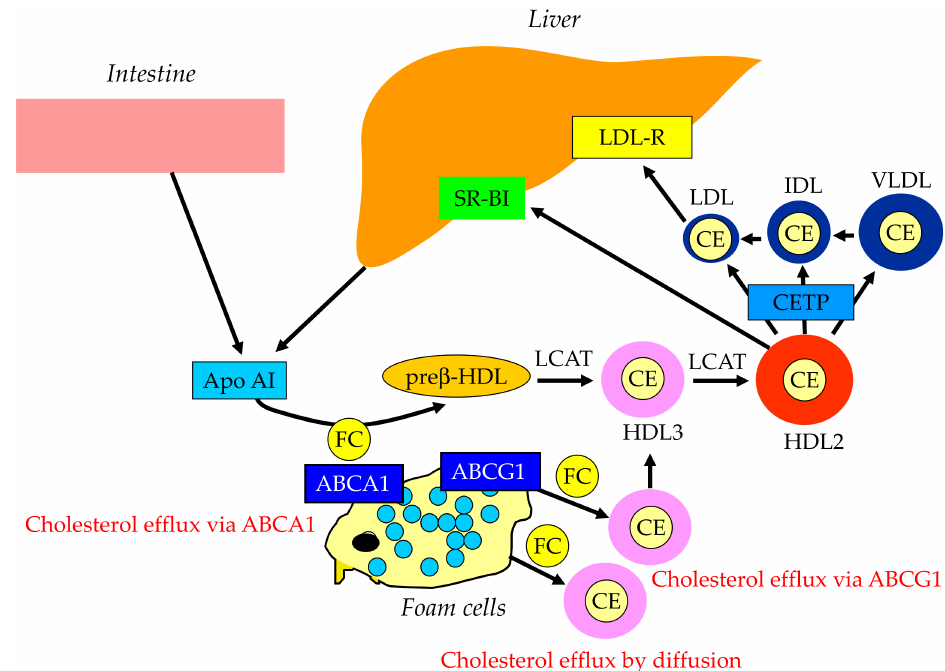
Figure 3. Reverse cholesterol transport. ABCA1, ATP-binding cassette transporter A1; ABCG1, ATP- binding cassette transporter G1; CE, cholesterol ester; CETP, cholesterol ester transfer protein; FC, free cholesterol; HDL, high-density lipoprotein; IDL, intermediate-density lipoprotein; LDL, low-density lipoprotein; LDL-R, low-density lipoprotein receptor; LCAT, lecithin–cholesterol acyltransferase; SR-BI, scavenge receptor BI; VLDL, very-low-density lipoprotein. 3. What Is the Statin Residual CVD